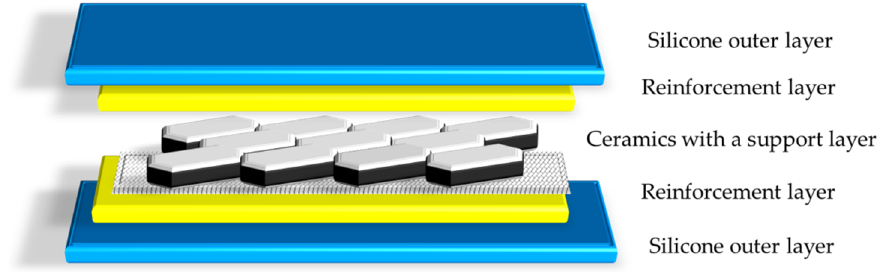
Figure 2. Diagram of the construction of a hybrid silicone-ceramic composite.